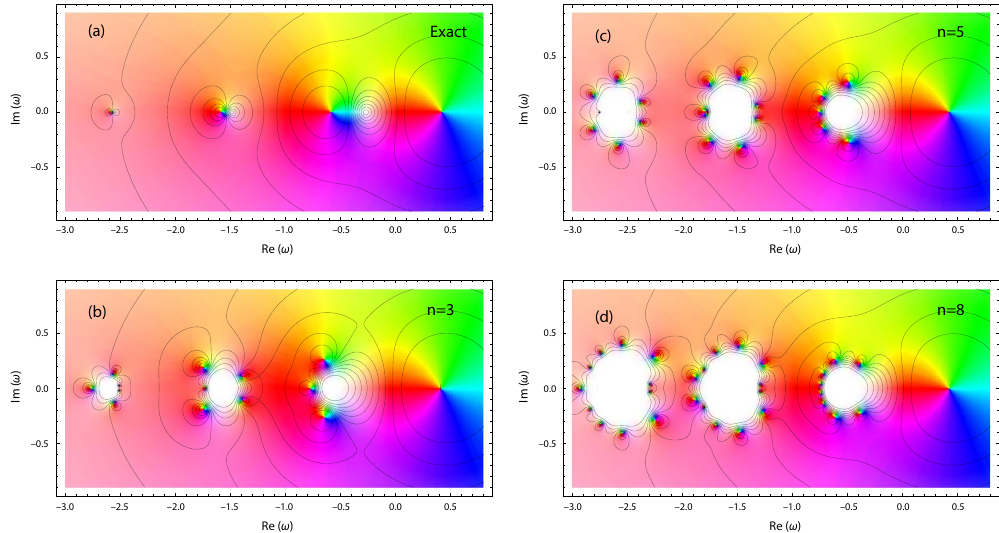
Figure 4. Electron Green’s function g ( ω ) resolved in complex plane for Ω = 1 and γ = 0.65. Approximations are computed using SE of orders 3 ( b ), 5 ( c ), and 8 ( d ) and compared to the exact solution ( a ). For g ( ω ), the hue channel represents the arg[ g ( ω )], the saturation channel represents the modulus | g ( ω )|, and the contour plot depicts tanh | g ( ω )|.